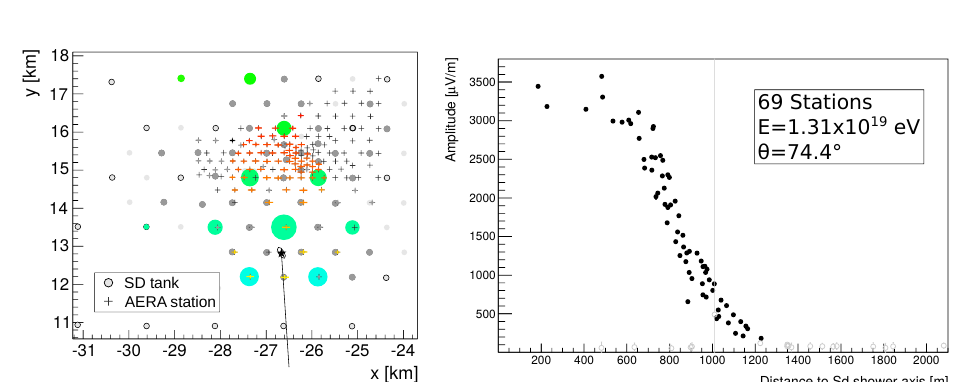
Figure 5. Example event of a horizontal air shower with the current AERA set-up. The grid of the surface detector stations and antenna stations can be seen on the left and on the right the radio lateral distribution can be seen. The color scheme of the SD tanks and the AERA stations on the left indicate the timing information of the triggered tanks and stations and thus the arrival direction of the shower. The size of the circles indicates the signal